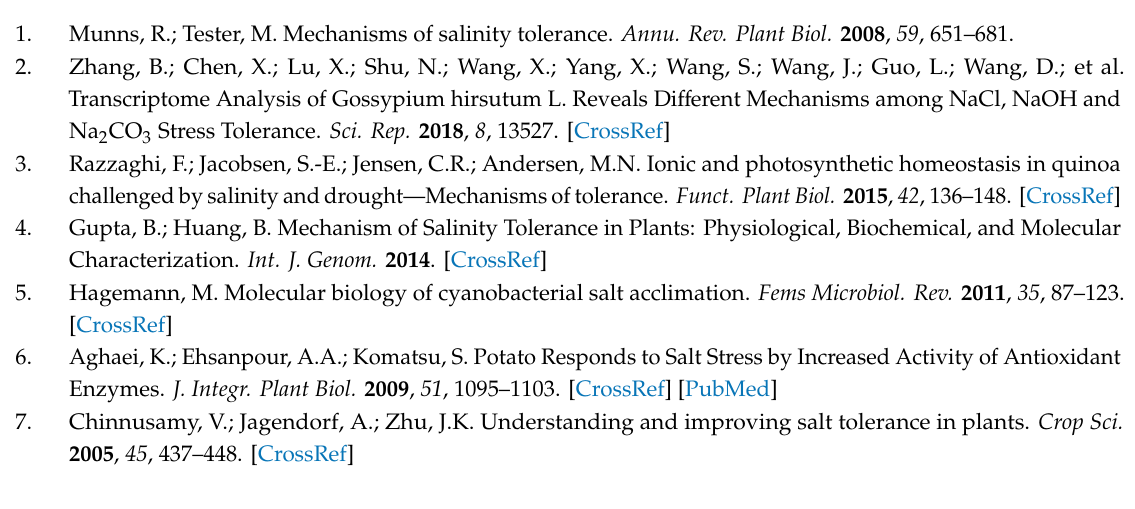
Supplementary Materials: Supplementary File 1. Supplementary materials can be found at http: //